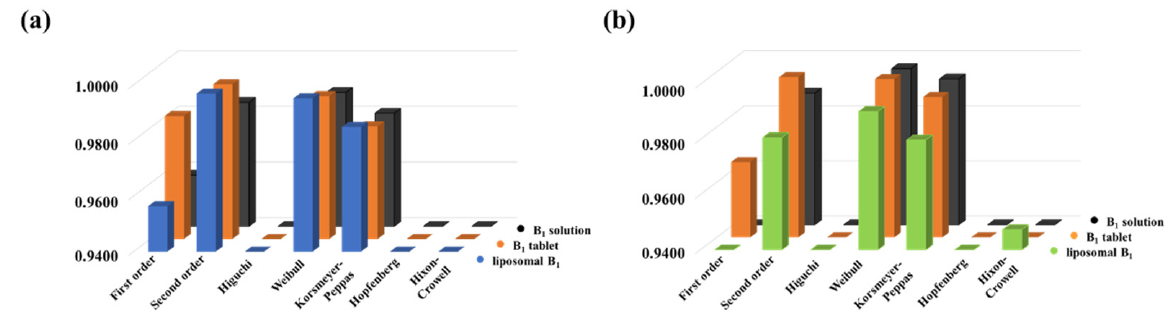
Figure 5. The correlation coefficients (R 2 ) for the release curves fitted with various kinetic models under ( a ) physiological and ( b ) acidic conditions.